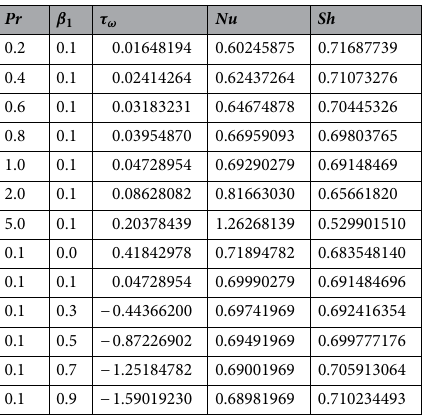
Table 1. Values of τ ω , Nu and Sh for various values of Pr and β 1